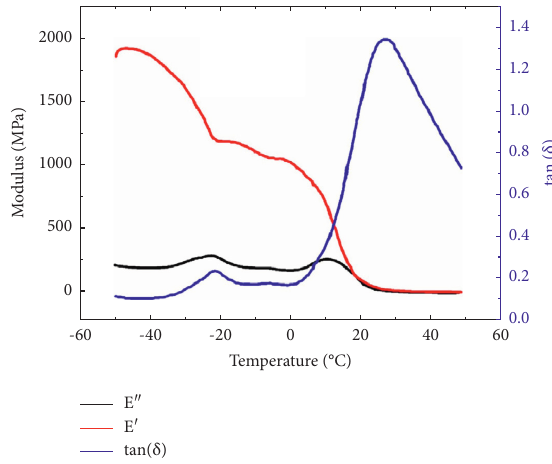
Figure 22: DMA properties versus temperature for EA [17]. Table 2: T g and damping properties of the neat EP and HMEA